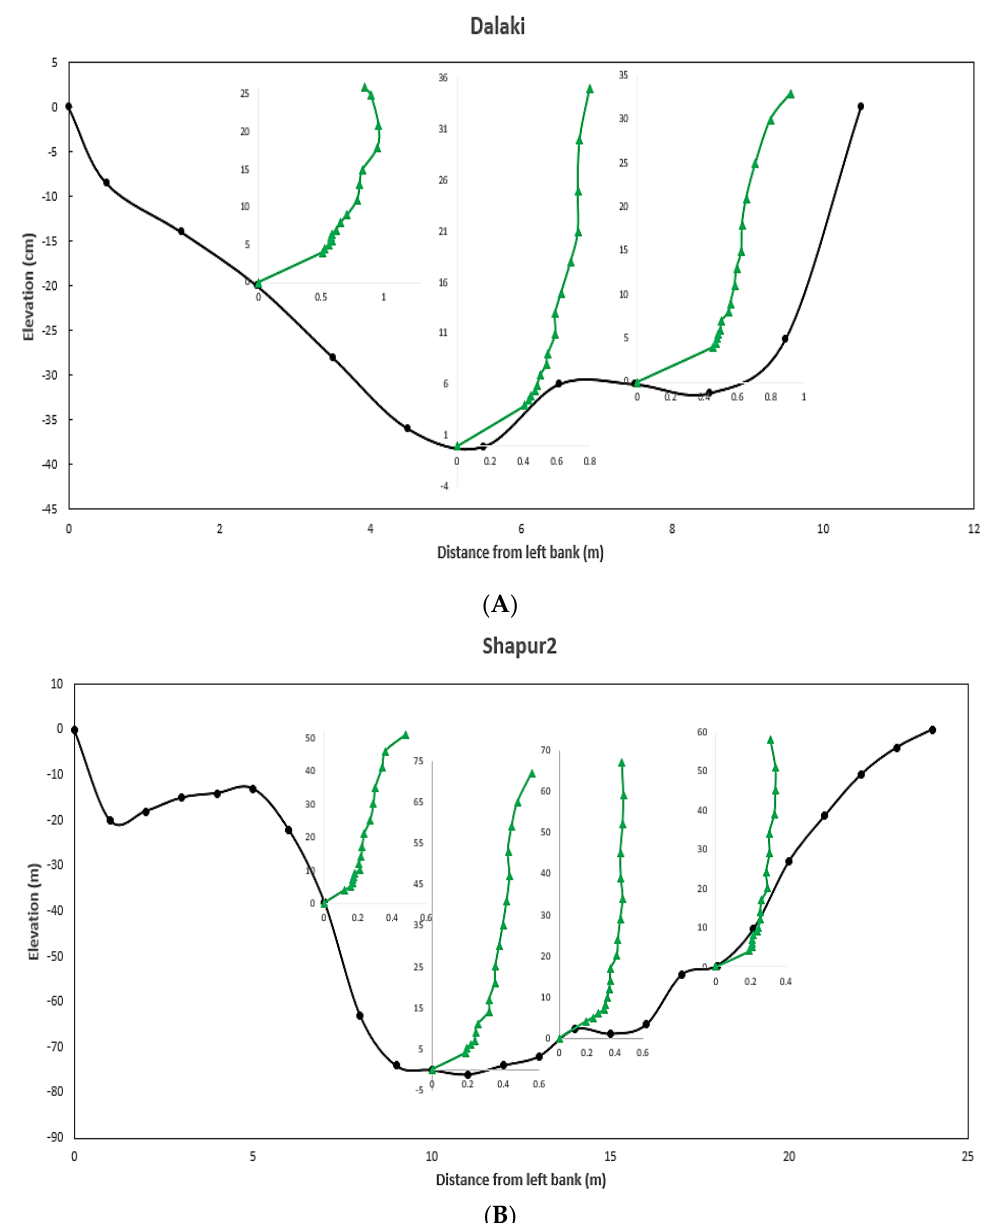
Figure 9. Cross − section and velocity profiles measured in ( A ) Section No. 1 from Shapur1; ( B ) Section No. 2 from Fahlyan reach.